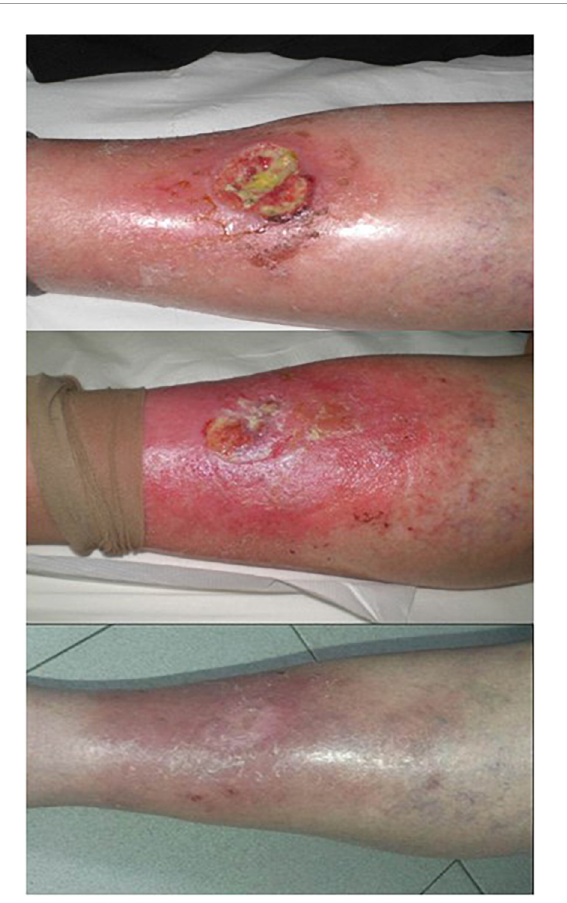
FIGURE5 Effective use of PDT on chronic leg ulcer. Up: a 67 years old woman presenting a chronic leg ulcer on the left tibia. Middle: almost complete healing of the ulcer after five treatments (15 weeks). Down: complete healing of the ulcer in 12-month follow-up (figure adapted from the reference 109 with permission of John Wiley and